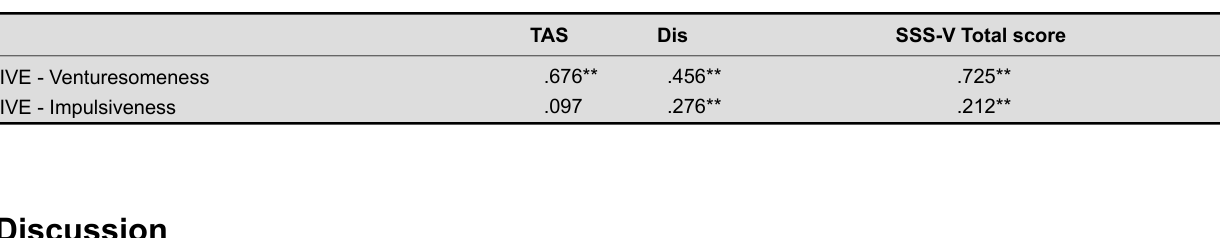
Correlations With the Impulsiveness Questionnaire